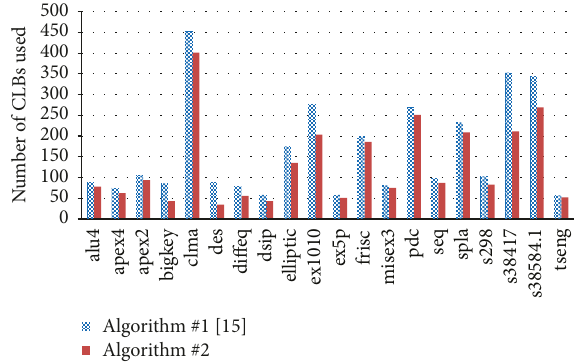
Figure 7: Number of CLBs utilized for cluster size of 𝑁 = 10 and 𝑝 = 1 – 5 .